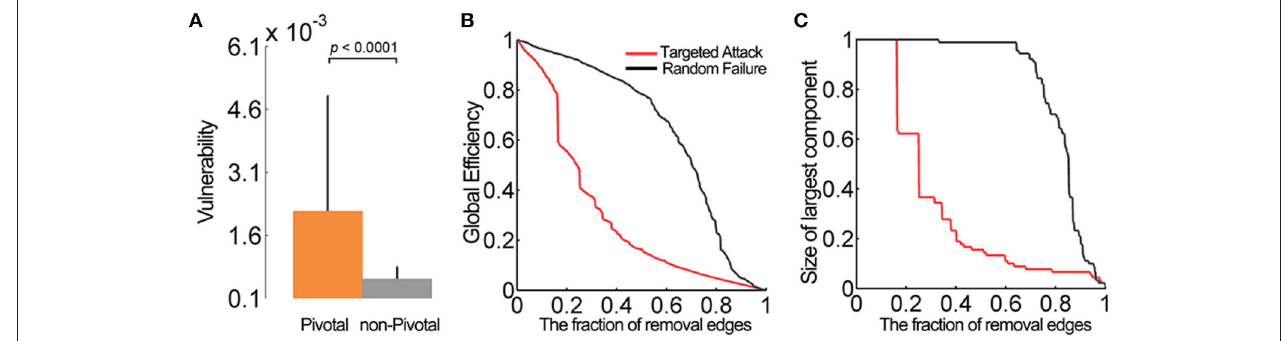
FIGURE 6 | Vulnerability of the pivotal edges and lesion simulation. (A) The pivotal edges showed significant greater vulnerability than the non-pivotal ones. The error bars represent the standard deviation. (B) The global efficiency and (C) the size of largest connected component slowly declined in the random failure. When facing the targeted attacks, these network properties decreased rapidly (over 40%) after the top 20% edges were